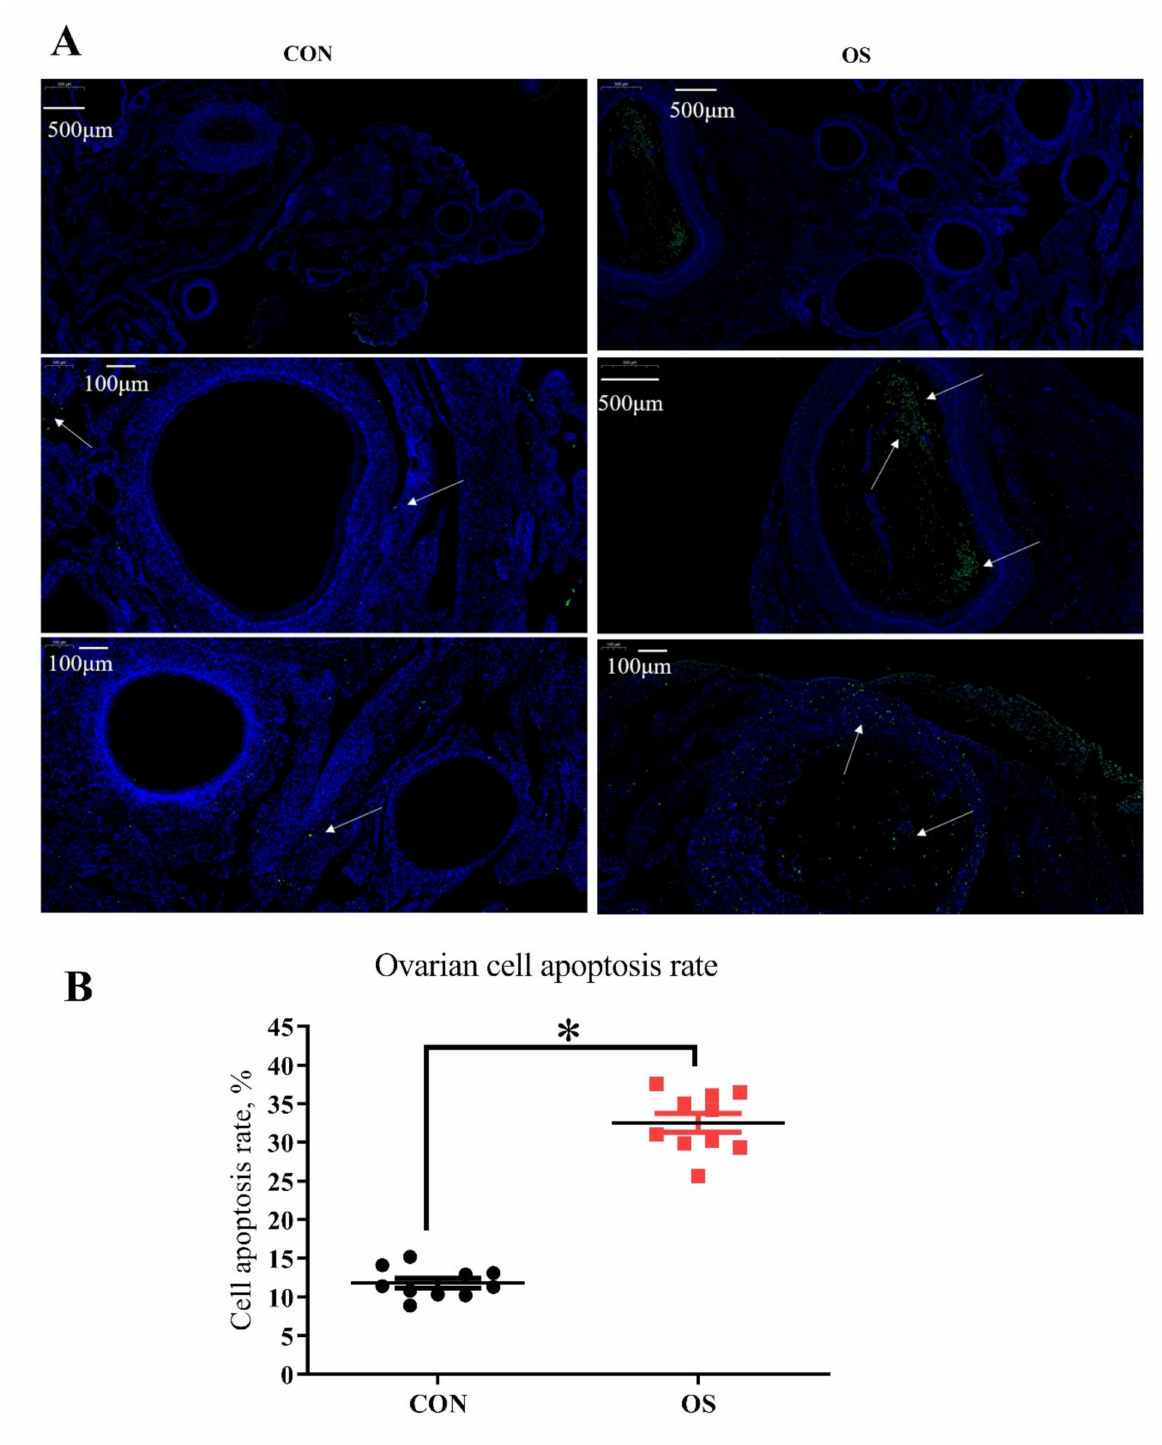
Figure 3. Oxidative stress (induced by tBHP) increased the cell apoptosis rate of ovary (Experiment 1). ( A ) TUNEL analysis for cell apoptosis in ovary; ( B ) The immunofluorescence results of TUNEL with the green color presents the positive cells. Data are plot individual values ( n = 10). CON = same dosage of PBS, OS = 800 µ mol/kg BW of tBHP. Statistical significance was evaluated by t -test, * p <